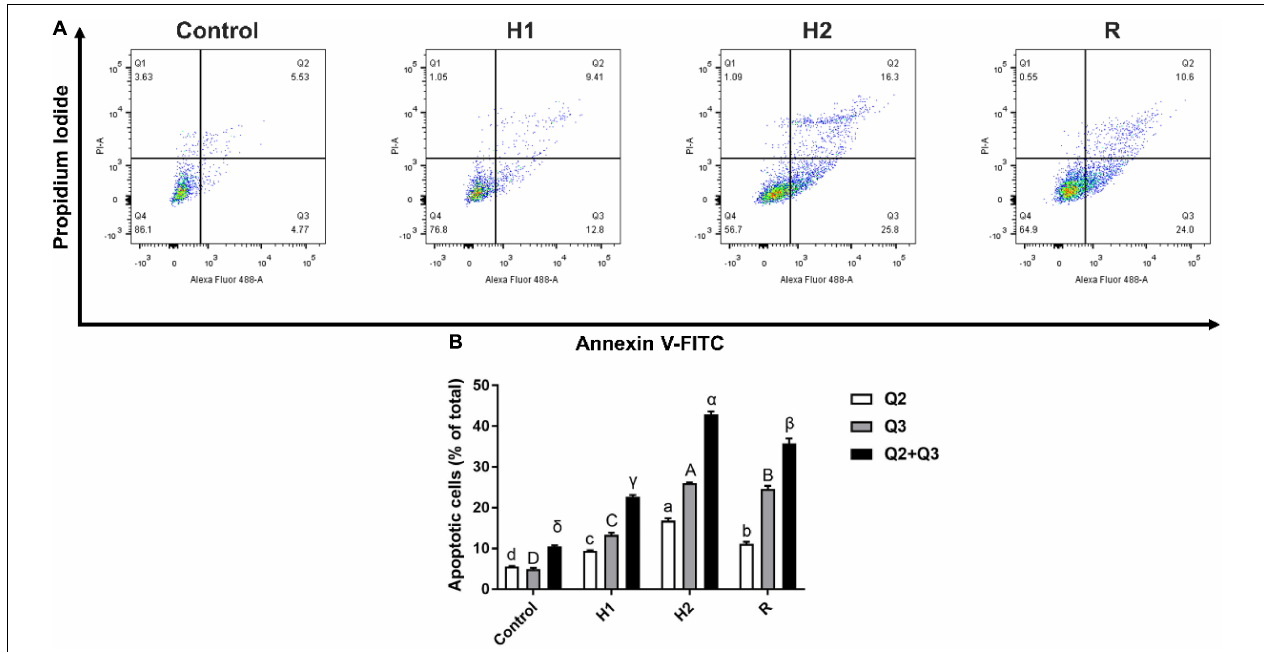
FIGURE 2 | Effect of apoptosis in the blood cell of largemouth bass under acute hypoxia and reoxygenation. (A) Cell apoptosis rate was determined by flow cytometry. (B) Bar graph of apoptosis due to normoxia and hypoxia. Data are expressed as the mean ± SD ( n = 3; one-way analysis of variance followed by the T -test). All experiments were conducted in triplicate. Different letters denote significant differences ( P < 0.05).